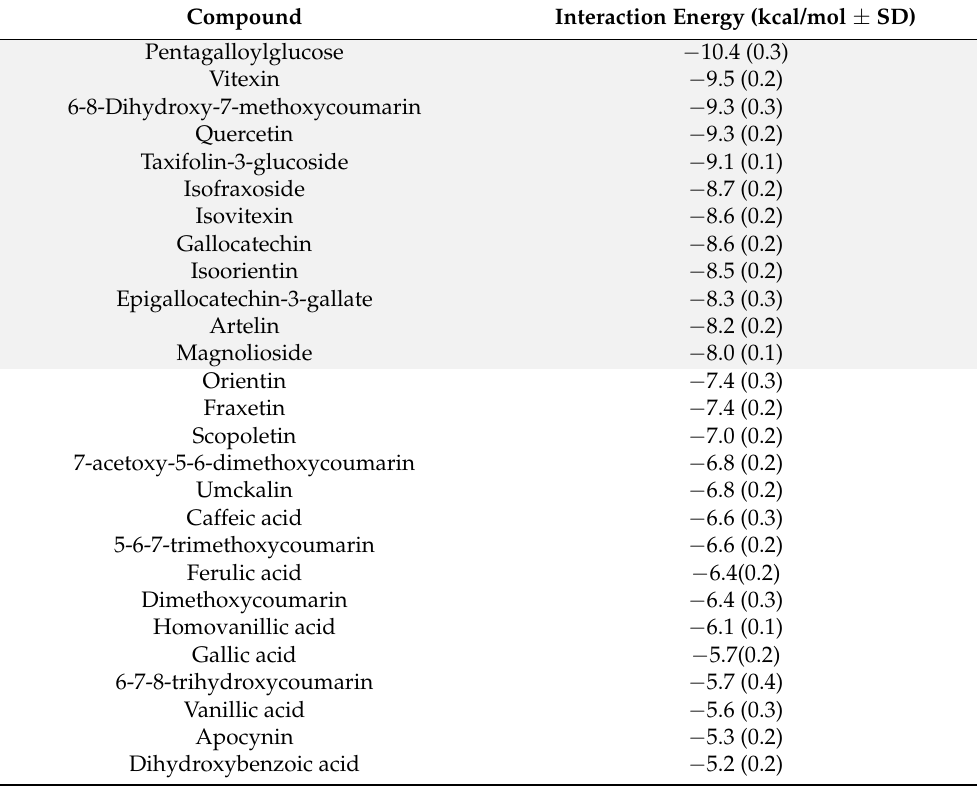
Table 5. Spike glycoprotein molecular docking results. The average interaction energy calculated from three independent docking runs, including standard deviation, is reported for each compound.